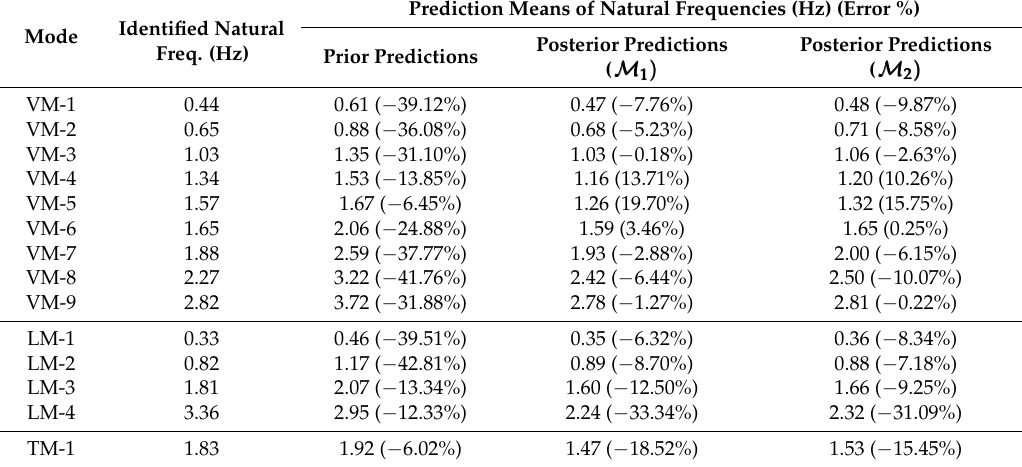
Figure 10. Prior and posterior predictions of natural frequencies for model class M 1 and M 2 . Table 6. Identified frequencies, prior and posterior prediction means of frequencies, and the corresponding errors compared with the identified frequencies.